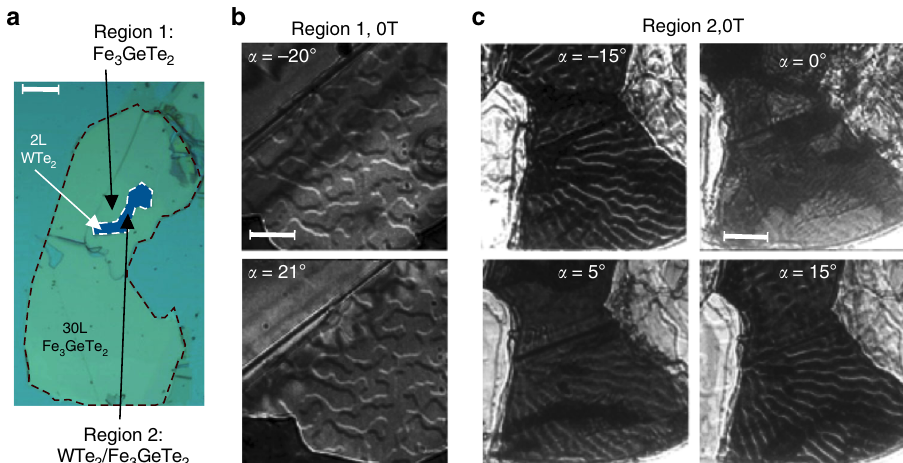
Fig. 4 Magnetic domain difference of Fe 3 GeTe 2 with and without WTe 2 . a Sample for Lorentz transmission electron microscopy measurements consisting of 2L WTe 2 and 30L Fe 3 GeTe 2 . Scale bar: 10 μ m. b Typical labyrinth domain in 30L Fe 3 GeTe 2 thin fl akes. Scale bar: 2 μ m. c From the aligned and stripe-like domain structures of the WTe 2 /Fe 3 GeTe 2 , a Dzyaloshinskii – Moriya interaction energy is estimated to be ~1.0 mJ m − 2 . Scale bar: 2 μ ffiffiffiffiffiffiffiffiffiffiffiffi p δ ¼ 4 (cid:2) π j D j 36 . β is a phenomenological fi tting para- A K W eff meter and taken to be 0.31 for FGT 35 . A domain width of 290 nm